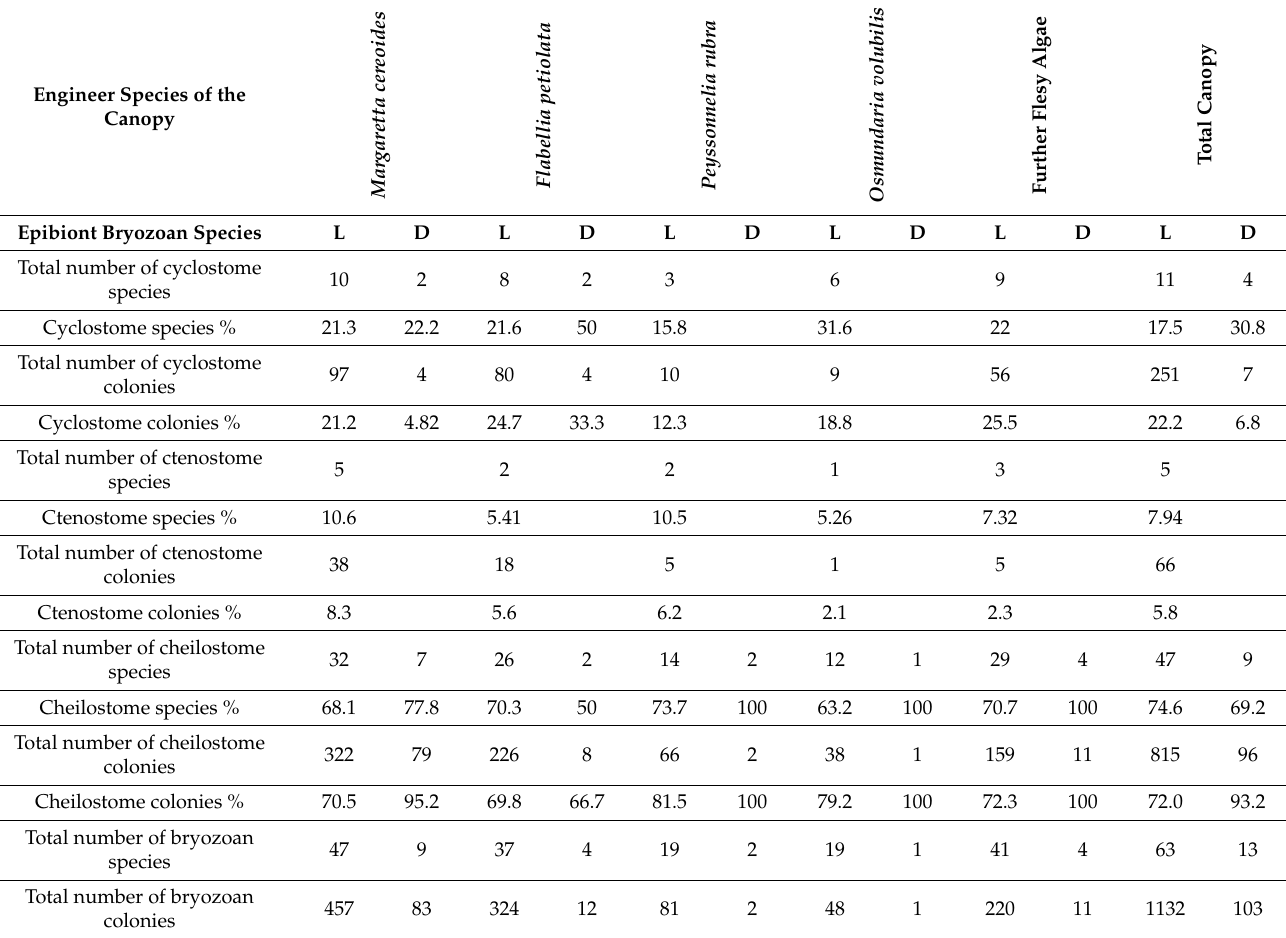
Table 2. Relevance (numbers and relative percentages) of the different bryozoan orders (cyclostomes, ctenostomes and cheilostomes) in the epibiont assemblages found on the bryozoan Margaretta cereoides and main algae of the canopy of the build-up E collected offshore Marzamemi (Ionian Sea). L: living and D: dead